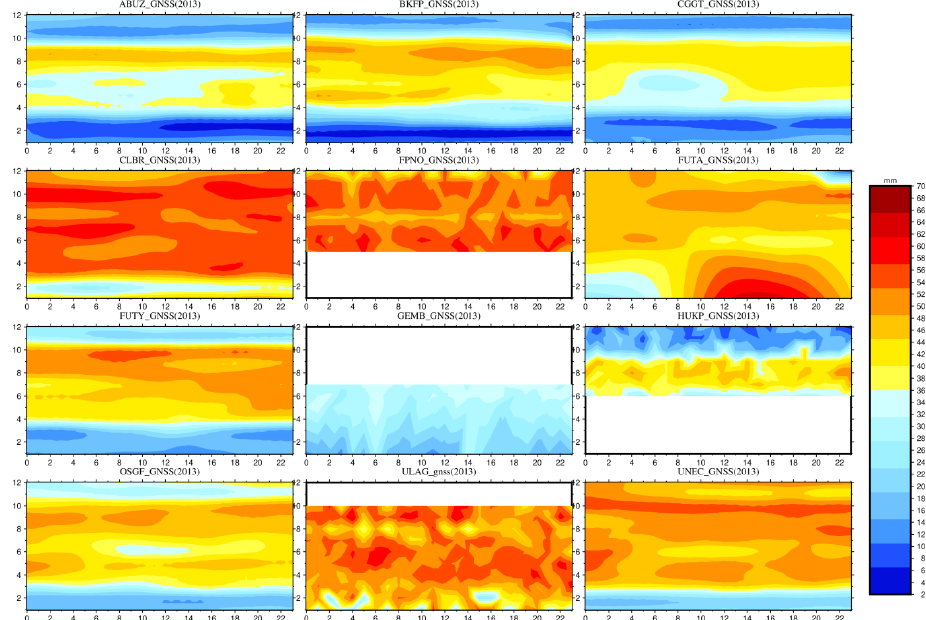
Figure 6. Sub-daily variation of GNSS PWV (mm) over 15 CORS for year 2013, plots are months against time